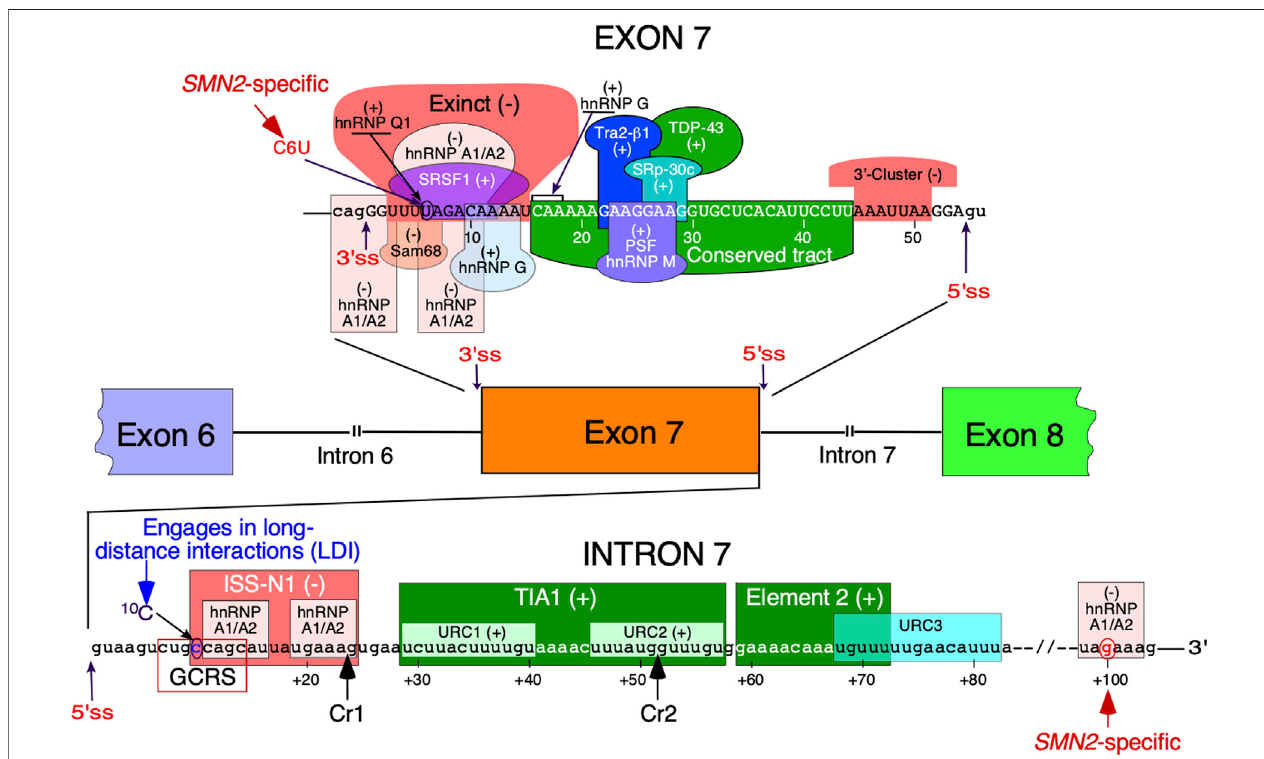
FIGURE1| Regulationof SMN exon7splicing.Diagrammaticrepresentationofintronicandexoniccis-elementsaswellastrans-actingfactorsthatmodulate SMN exon 7 splicing. Upper-case letters signify exonic sequences, small-case letters, intronic sequences. Exons and introns are also shown as colored boxes and lines, respectively. Numbering of nucleotides, neutral and positive, starts from the fi rst exonic and intronic position, respectively. The 5 and 3 ′ splice sites (5 ′ ss and 3 ′ ss) are indicated by thearrows. Exinct, conserved tract and the 3 ′ -Cluster are cis-elements revealed by in vivo selectionas described in (Singh et al., 2004b). Cr1 and Cr2 represent cryptic 5 ′ splice sites as described in (Singh et al., 2017a). Negative and positive regulators of exon 7 splicing are indicated by ( − ) and (+), respectively. Abbreviations: Exinct, extended inhibitory context, GCRS, GC-rich region; LDI, long-distance interaction; URC, Uridine-rich clusters.